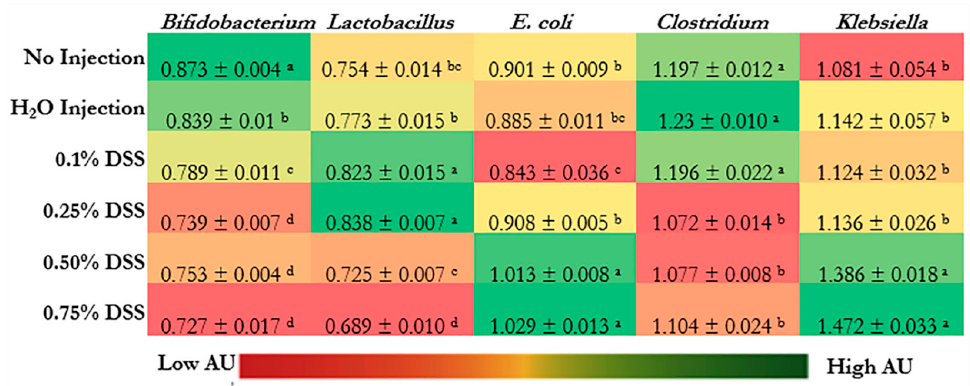
Figure 3. Effect of the intra-amniotic administration of DSS on cecal bacterial populations (day of hatch). Values are means ± SEM. Per bacterial category, a–d within a column, treatment groups that do not share letters are significantly different according to one-way ANOVA with Tukey’s post-hoc test ( p < 0.05).